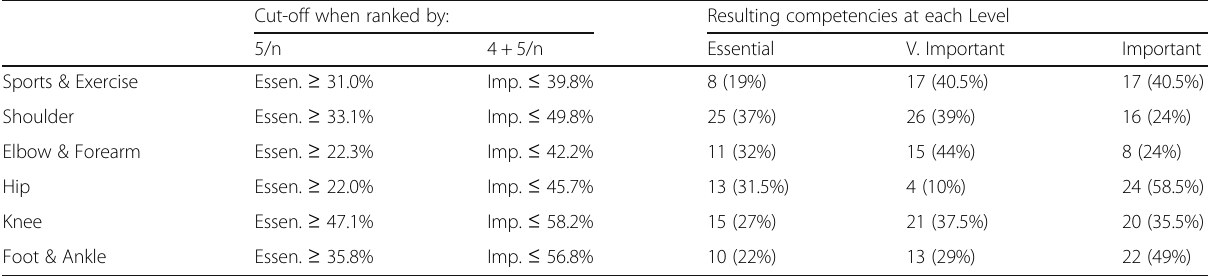
Table 1 Cut-offs between ranked competencies agreed by expert groups Cut-off when ranked